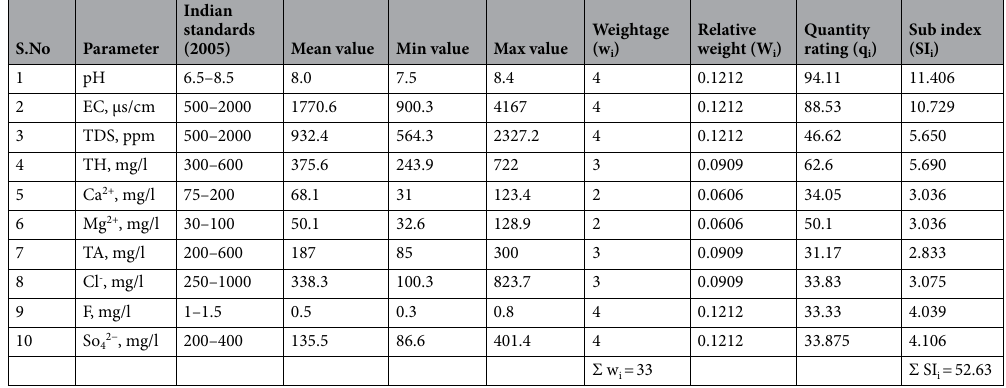
Table 4. WQI determination for 1995–2008.